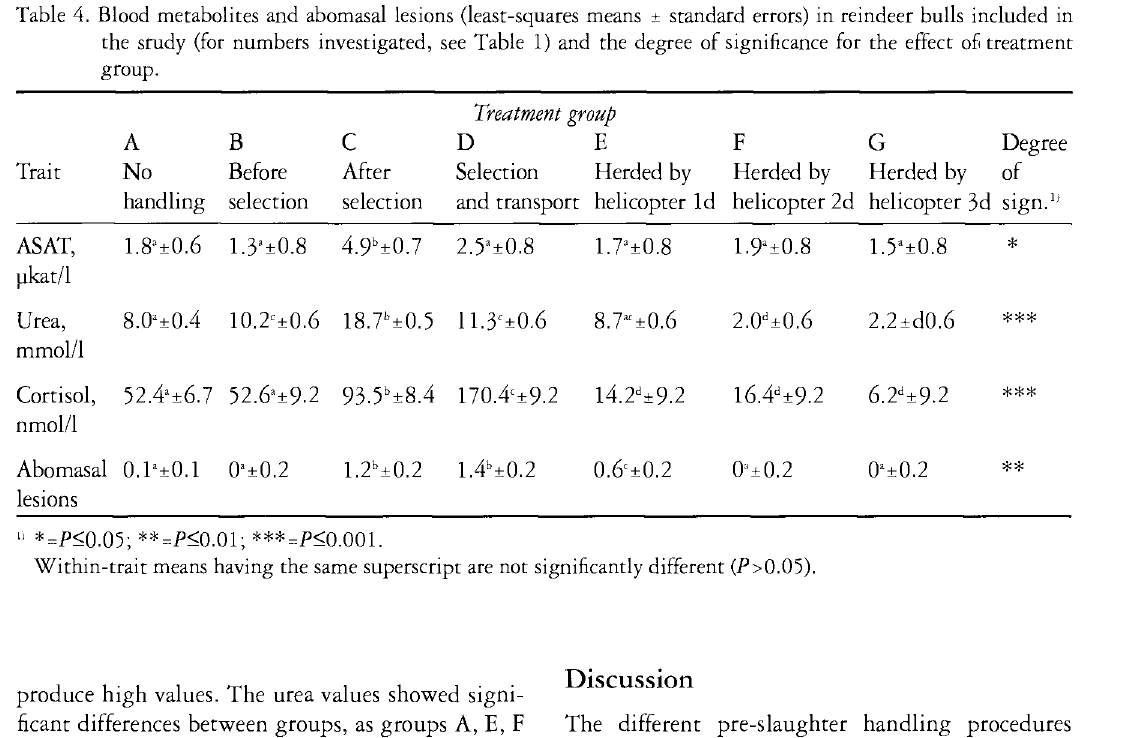
Table 4. Blood metabolites and abomasal lesions (least-squares means + standard errors) in reindeer bulls included in the srudy (for numbers investigated, see Table 1) and the degree of significance for the effect of treatment